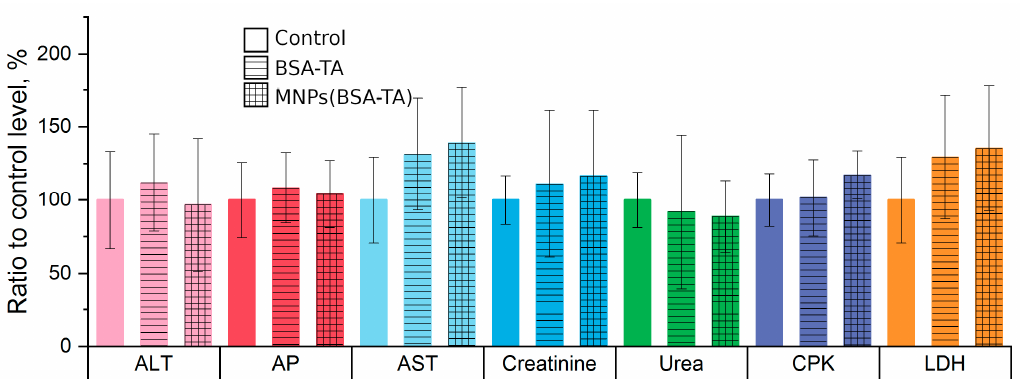
Figure 9. Effect of microcarriers on the level of biochemical markers (variables examined are shown as per cent of control group level). ALT—alanine transaminase, AP—alkaline phosphatase, AST—asparagine transaminase, CPK—creatine phosphokinase, LDH—lactate dehydrogenase. A statistically significant increase of LDH level and a tendency towards AST elevation was observed. Discussion in the text.